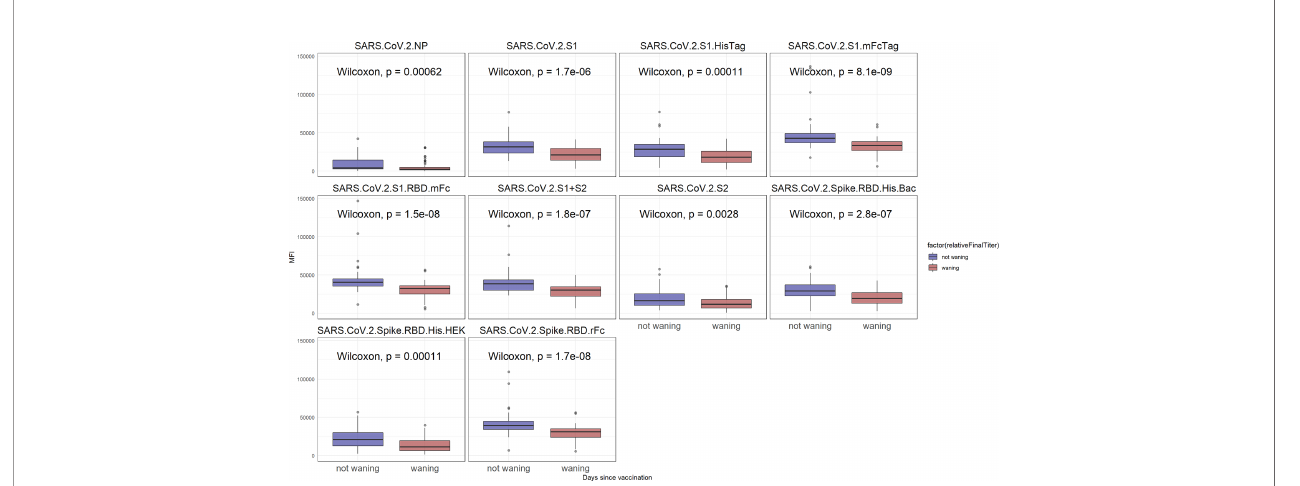
FIGURE 3 | SARS-CoV-2 reactivity after 6 months. In blue, are individuals for whom the reactivity did not signi fi cantly wane when compared to the day 80 time point. In red are samples for whom the reactivity has declined (p <